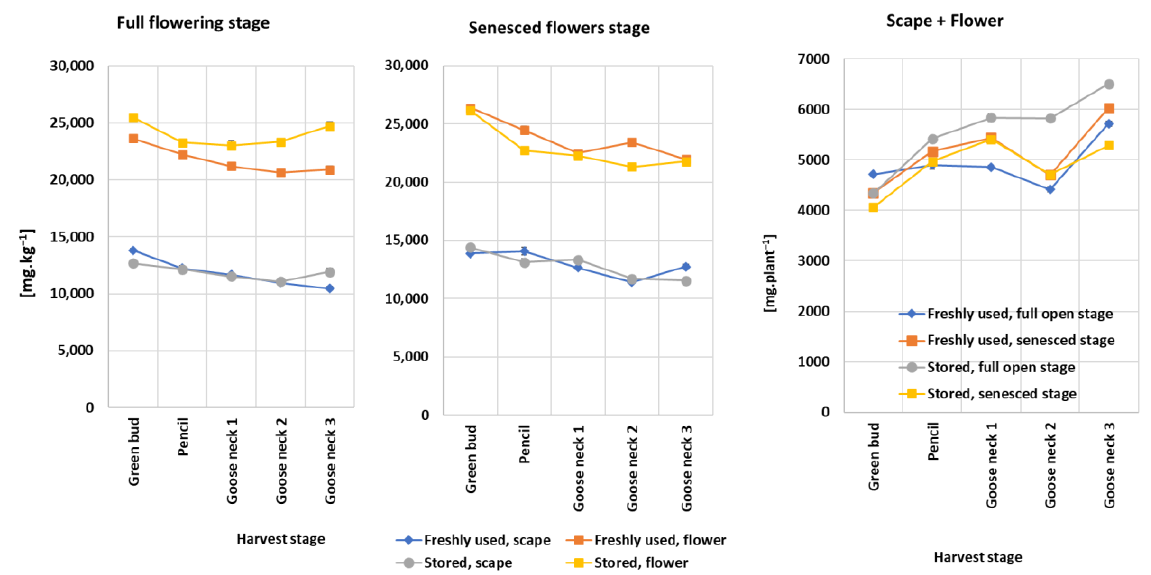
Figure 15. Water soluble potassium content. Bud stages: green bud (GB); pencil: white bud, upright (PE); goose neck 1: white bud, skew (GN1); goose neck 2: white bud, horizontal (GN2); goose neck 3: big white bud, horizontal, maximum with 1 opening petal (GN3).